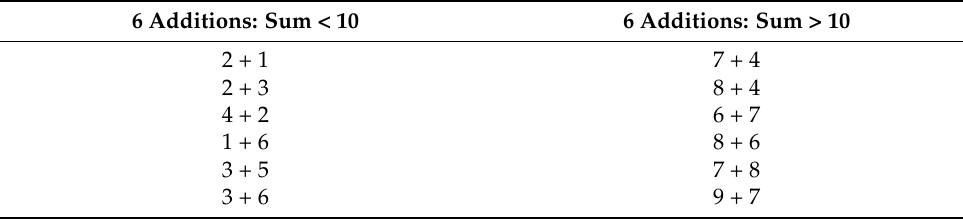
Table A1. List of problems used in the addition